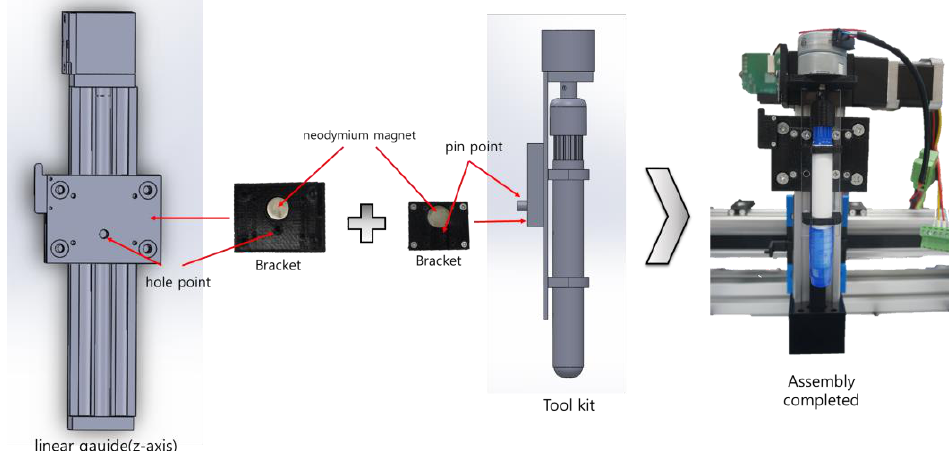
Figure 4. Structural diagram of the attachable/detachable toolkit.